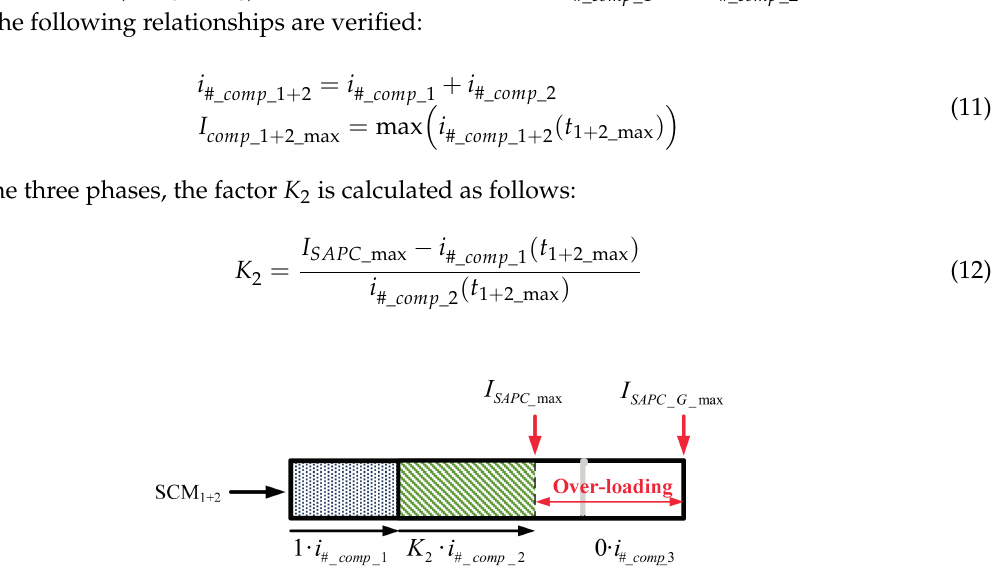
Figure 4. Block diagram of the SAPC limits of operation when SCM1+2 is executed.